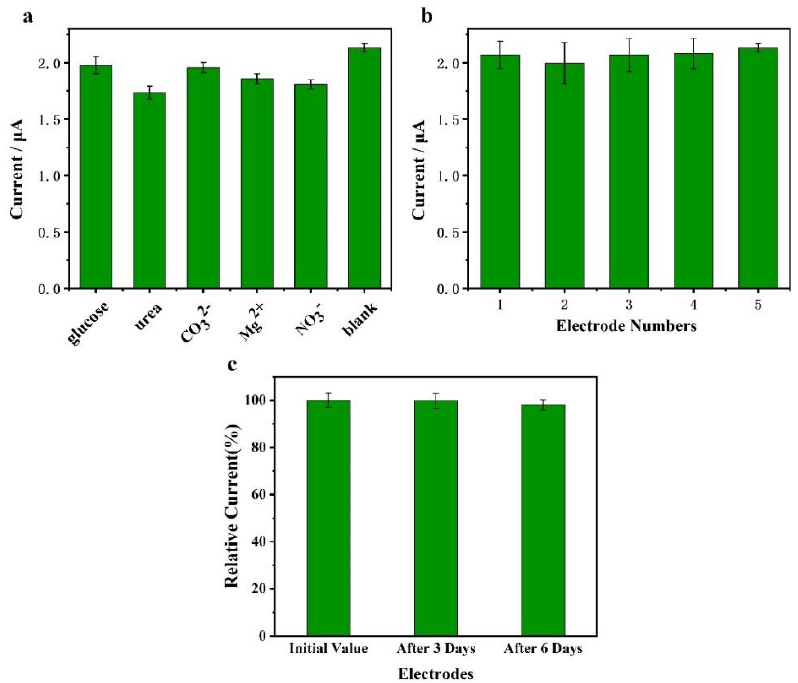
Figure 7. ( a ) Anti-interference, ( b ) Repeatability, ( c ) Stability tests of AChE-CS/GR/ZIF-8/GCE sensor.